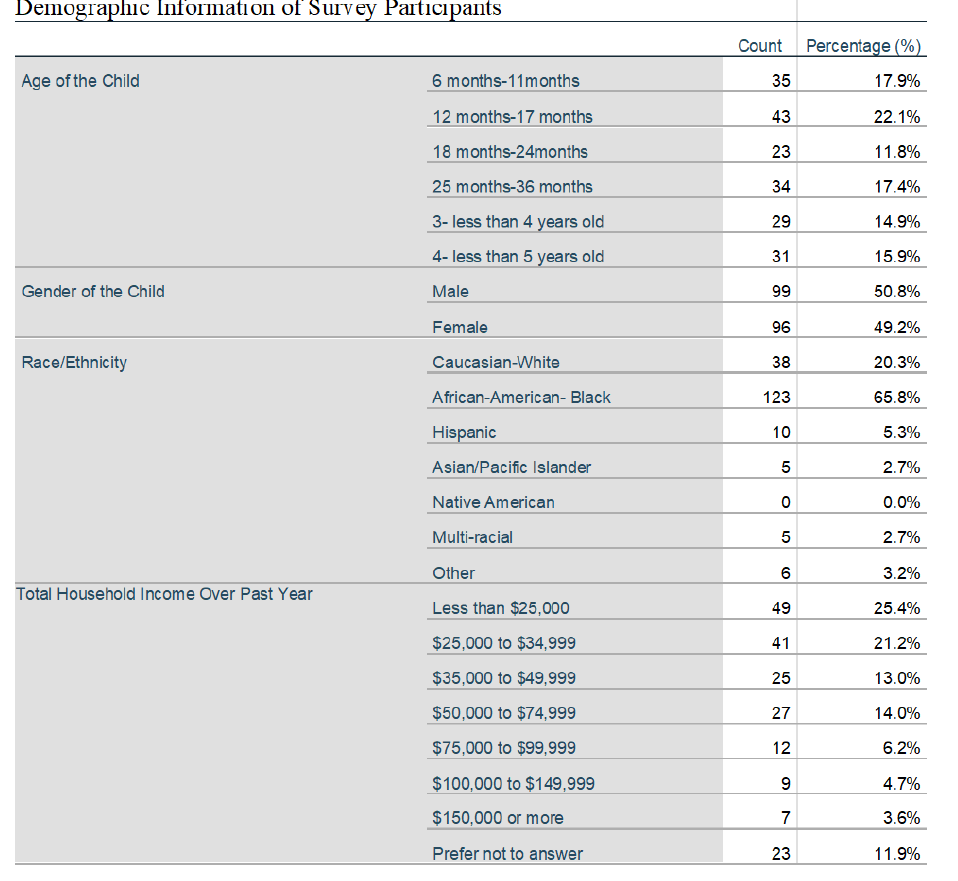
Figure 1. Describes demographic information for individuals who participated in the study from the CHKD GAP